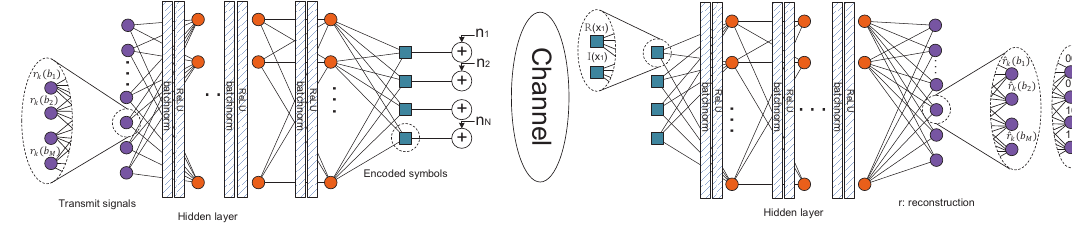
Figure 3. System model for DSM system.